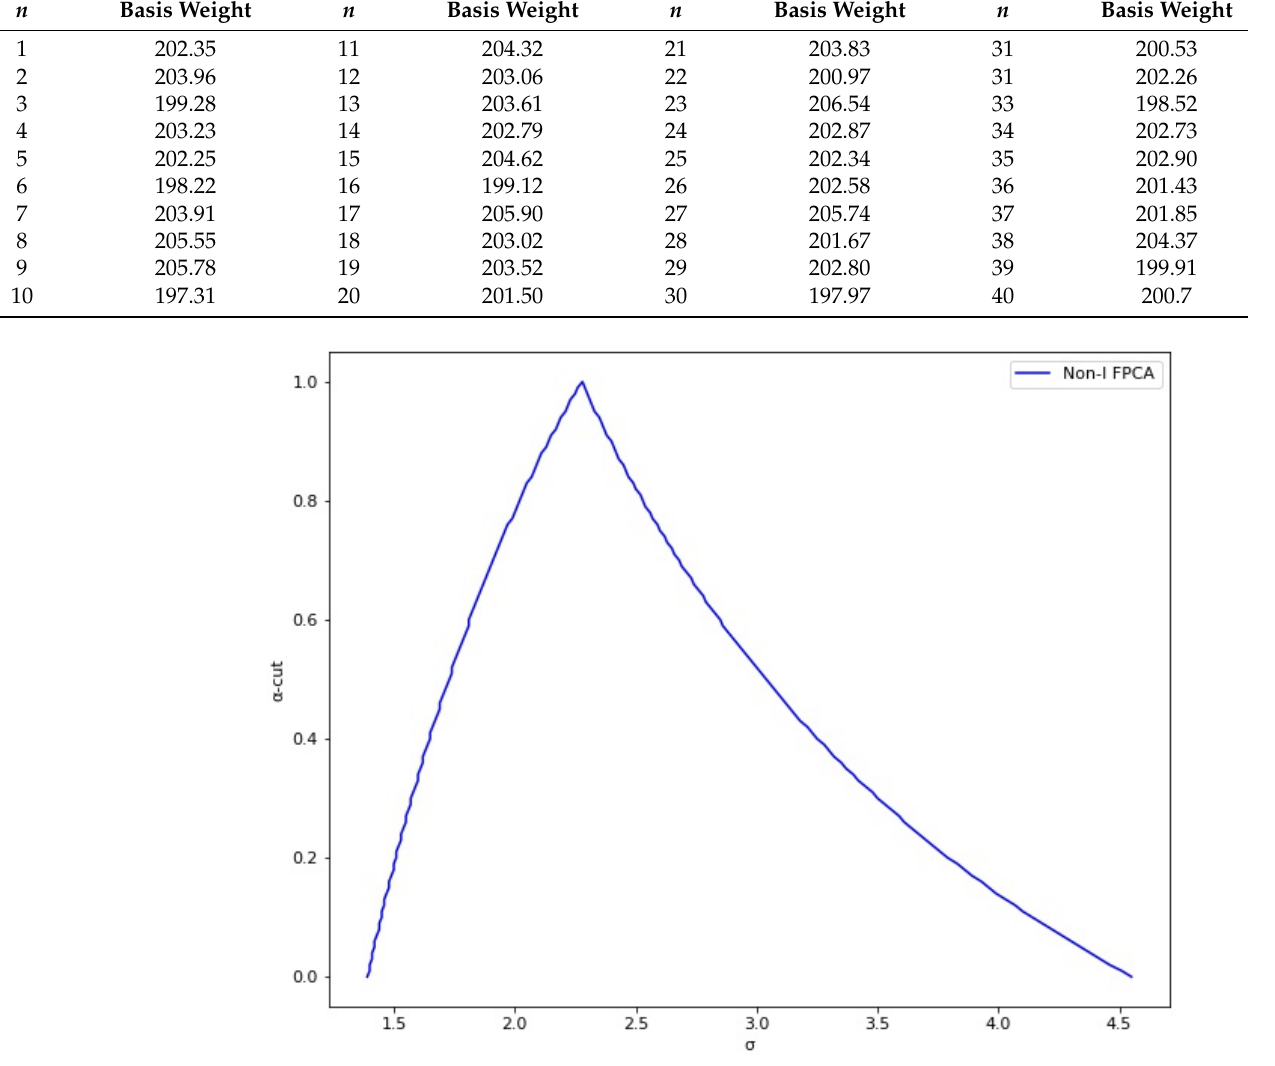
Figure 8. The membership function of ˆ σ c